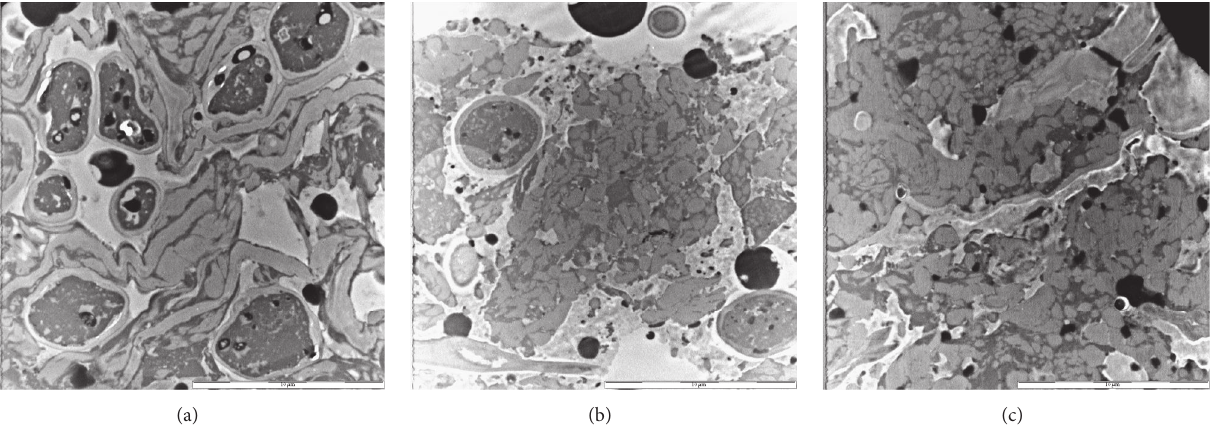
Figure 10: TEM Images of (a) CGM, (b) DDGS, and (c) CGM:DDGS 1: 1. Scale bar represents 10 𝜇 m.